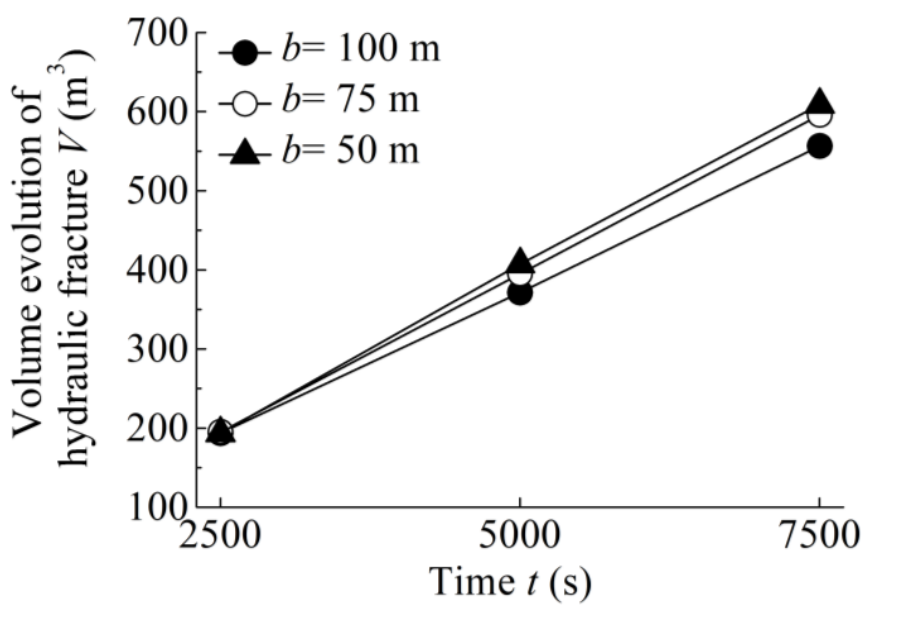
Figure 13. Length evolution of hydraulic fracture for different stages and well spacings.